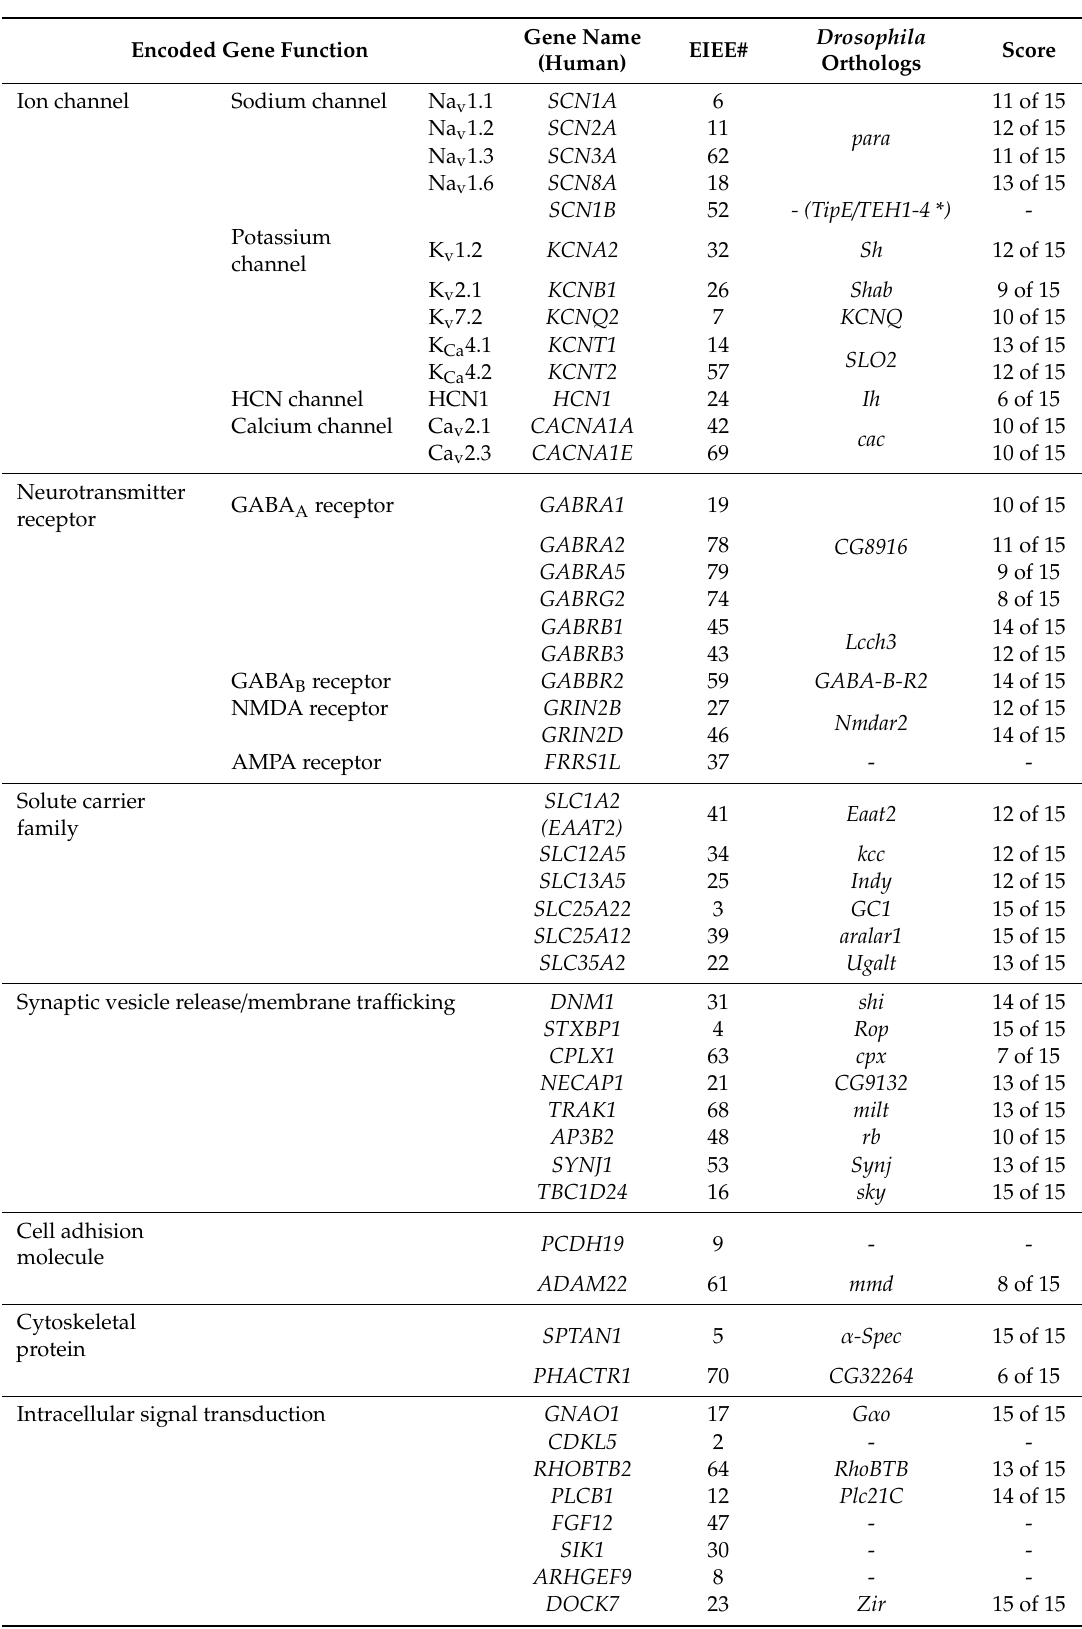
Table 1. Genes associated with early infantile epileptic encephalopathy